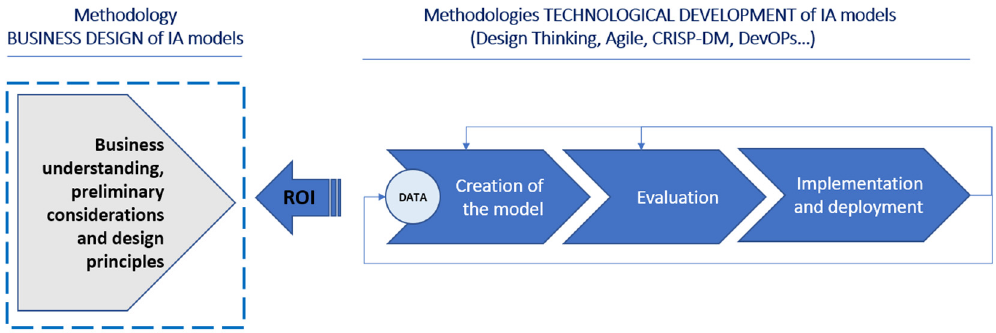
Figure 11. ROI feedback via IA Model results monitoring . Source: own elaboration.